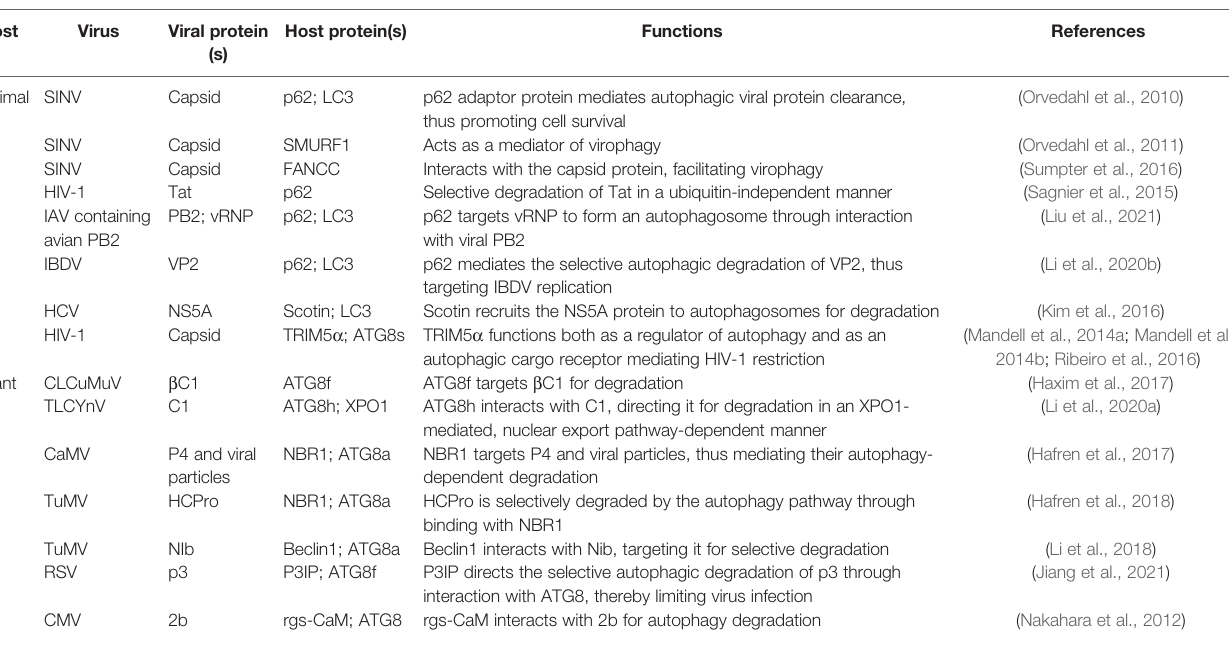
TABLE 1 | Autophagy-mediated antiviral immune